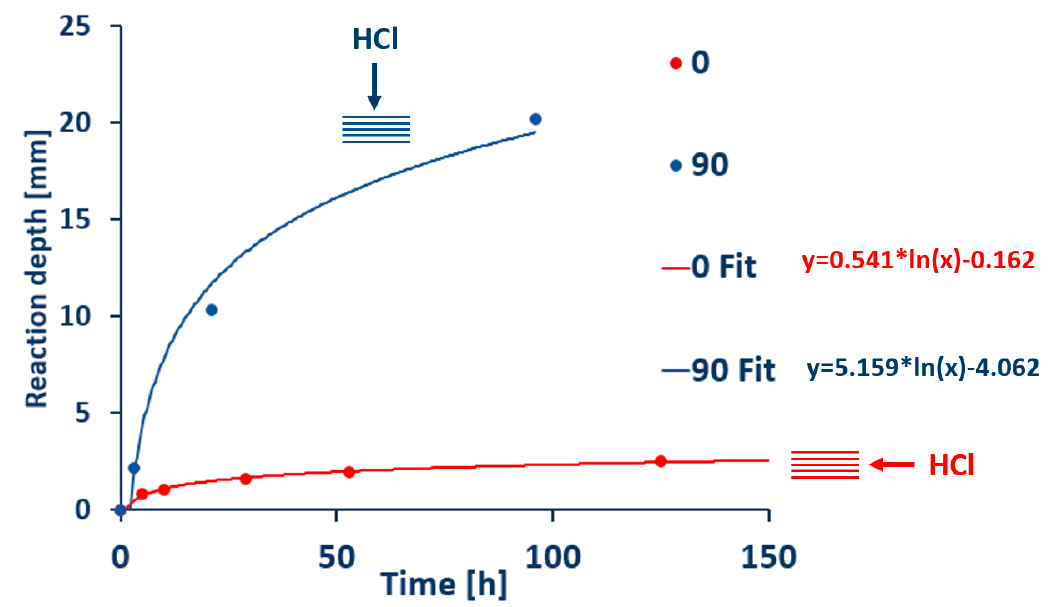
Figure 10. Reaction depth (distance from surface to the reaction front) vs time for sample A (parallel configuration-blue) and B (perpendicular configuration-red) with fitted logarithmic function.